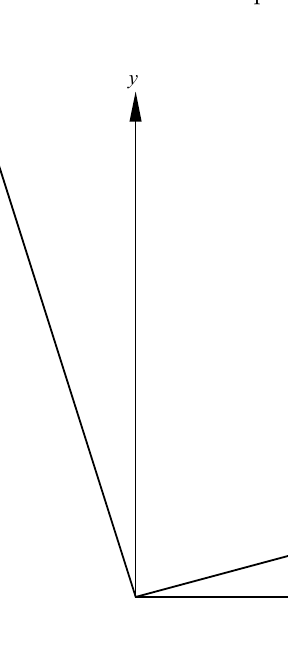
Figure 7. The carrier coordinate frame for the 2+1 NLS equation is given by the coordinate pair ( x , y ) . The rotated coordinate frame is defined by the coordinate pair ( X , Y ) . The particular rotation angle α is such that ( X , Y = 0 ) , i.e., there is a plane wave solution of the modulation moving in the direction X .